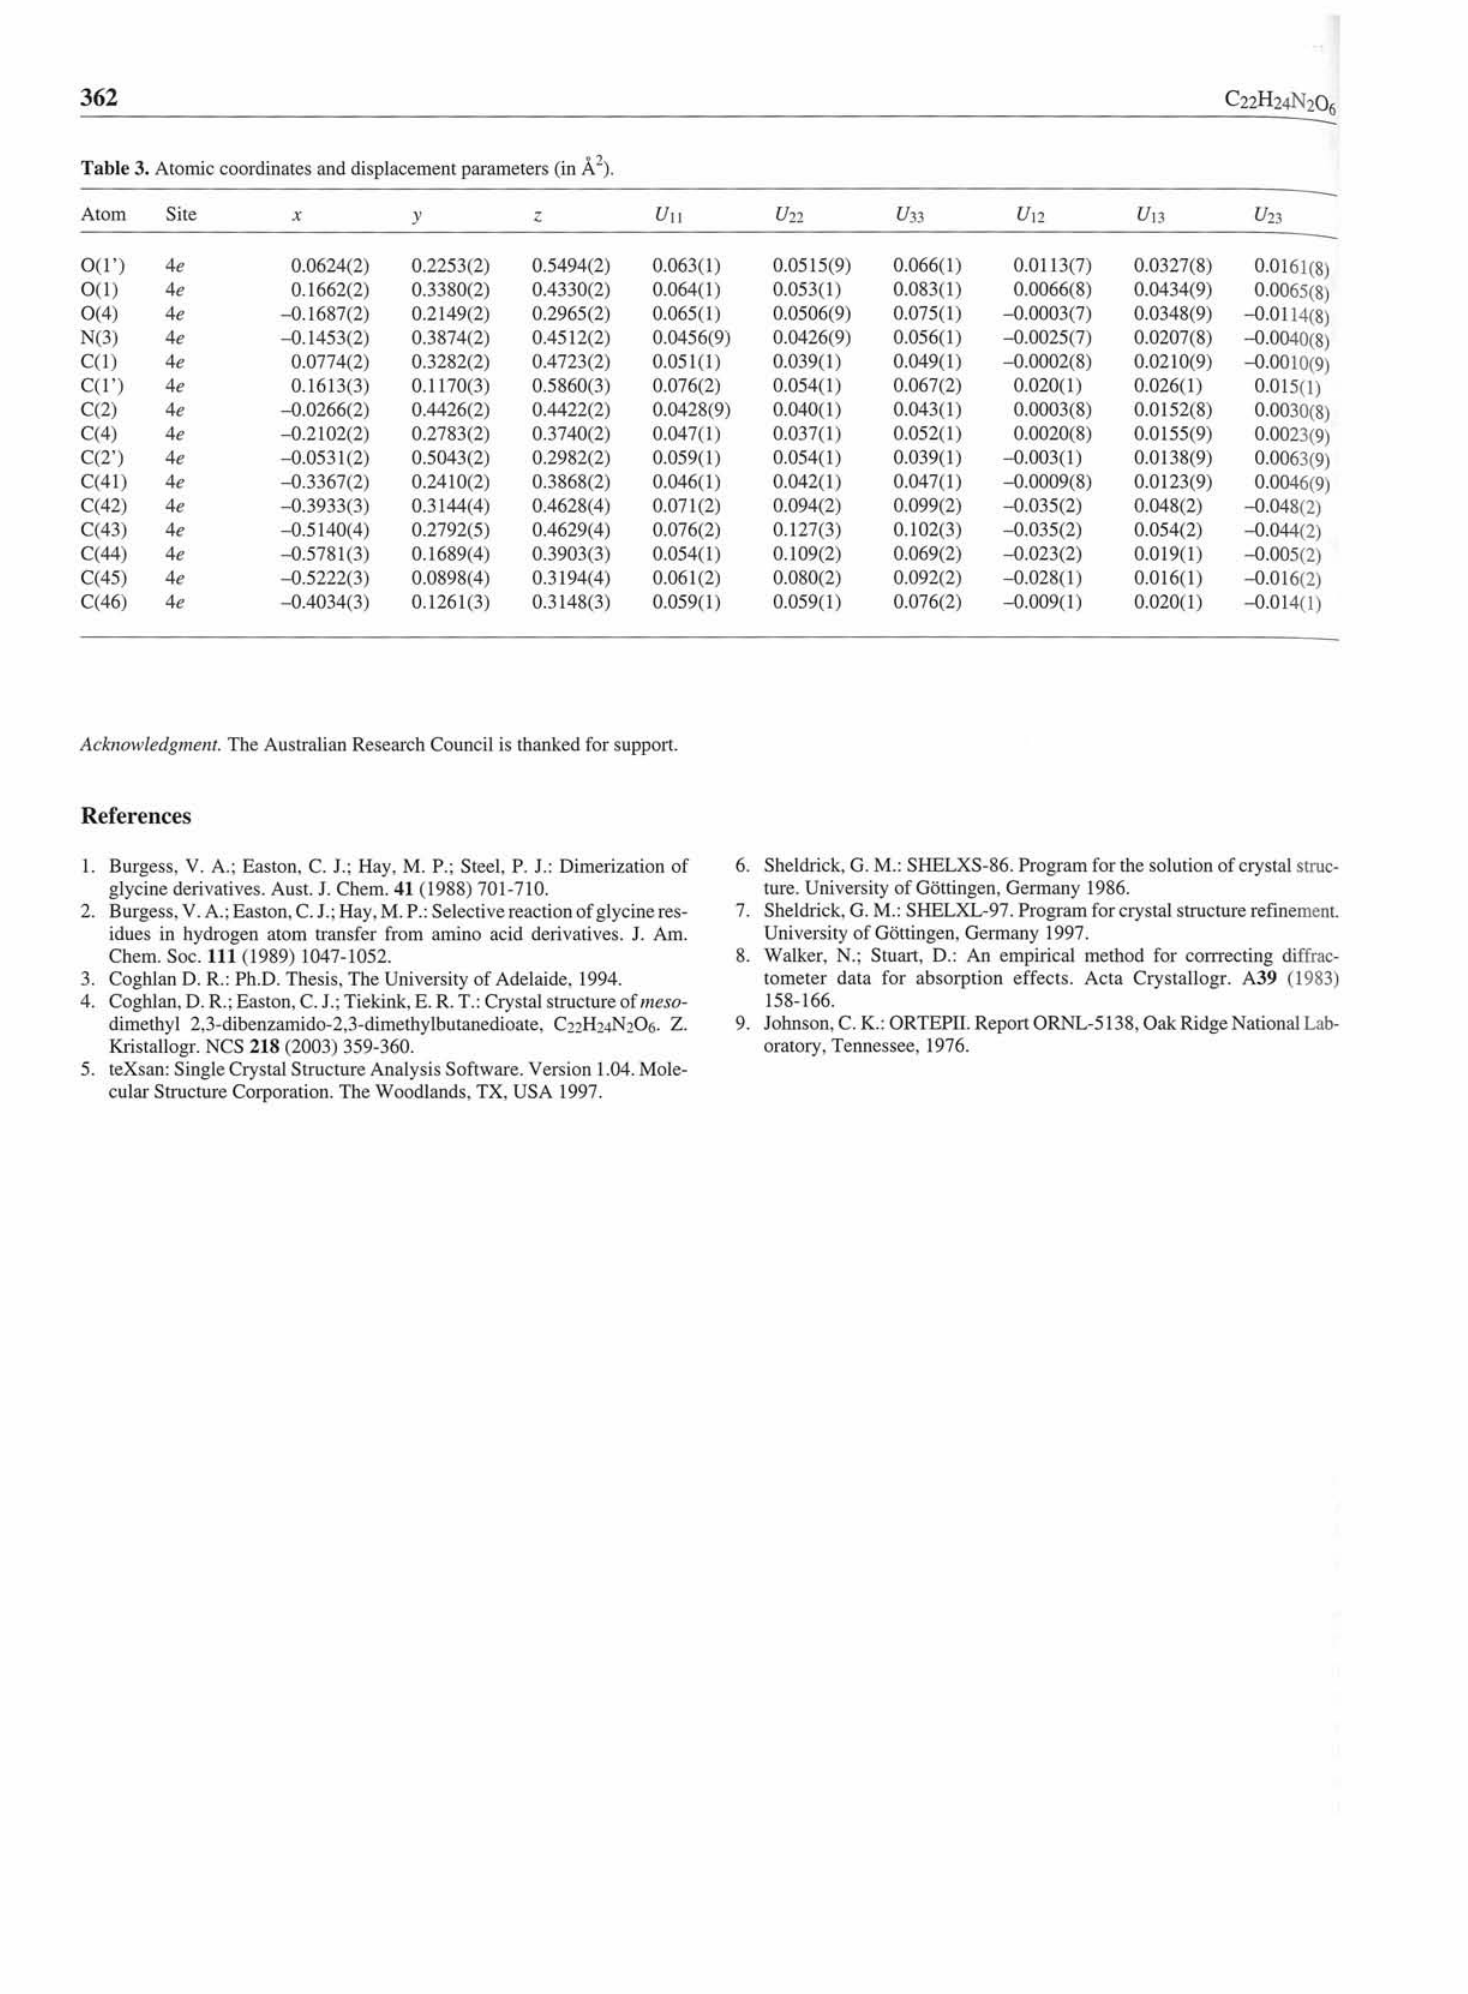
Table 3. Atomic coordinates and displacement parameters (in À 2